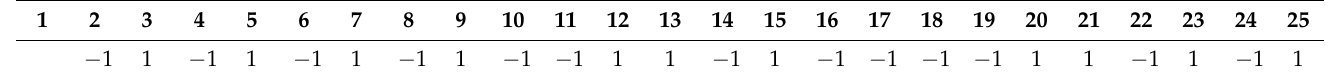
Table 18. Two-state time series of marker M4 along x -axis–the first difference, K q , t = 2,3, . . . ,25.